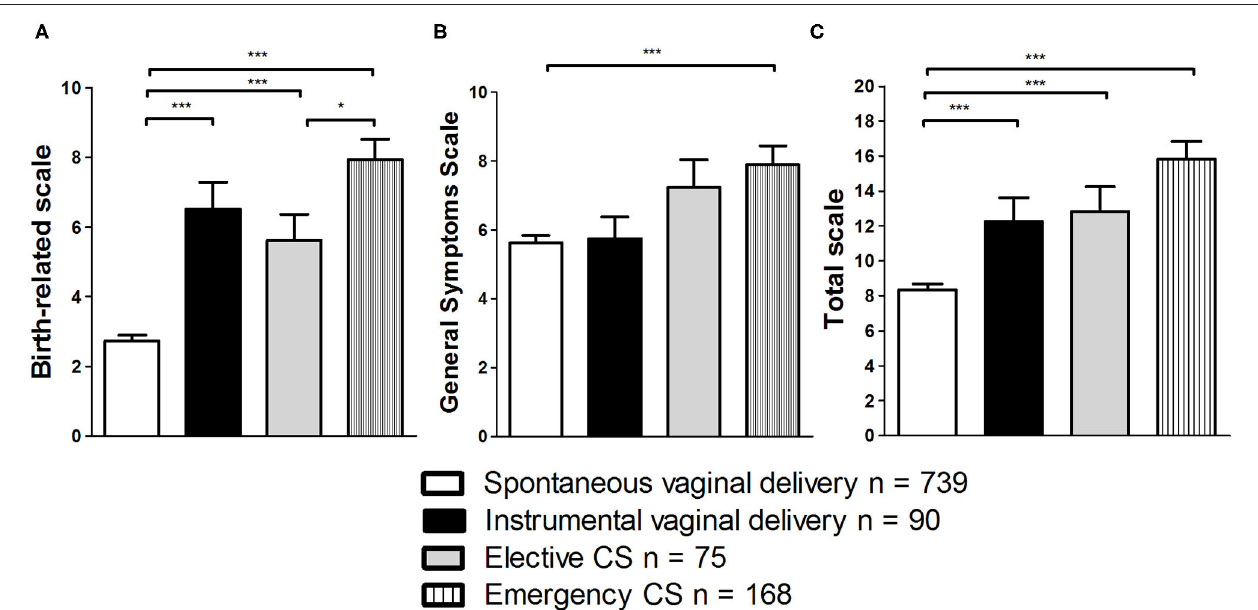
FIGURE 1 | Comparison of effects of type of delivery on scores in City BiTS subscales “Birth-related symptoms” (A) , “General symptoms” (B), and the total scale (C). * p < 0.05; *** p < 0.001. Data are shown as mean values ± SEM.